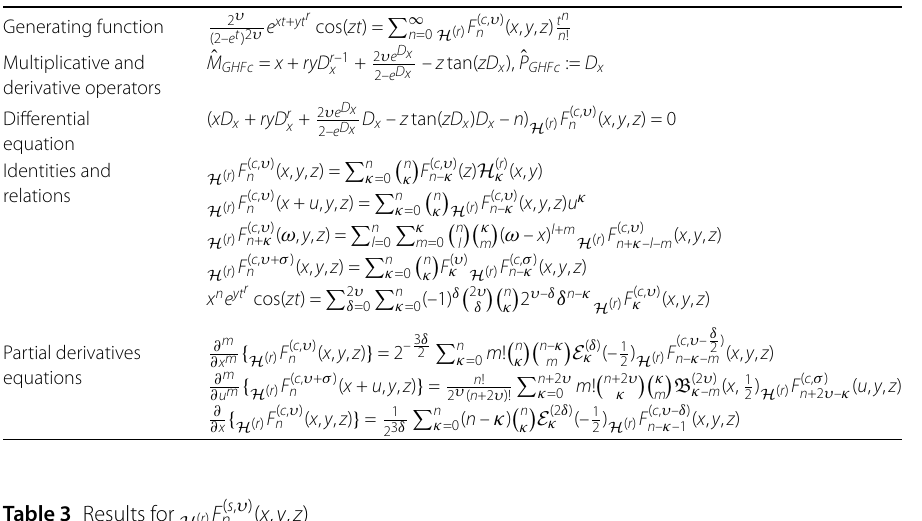
Table 3 Results for H ( r ) F ( s , υ ) n ( x , y , z ) Generating